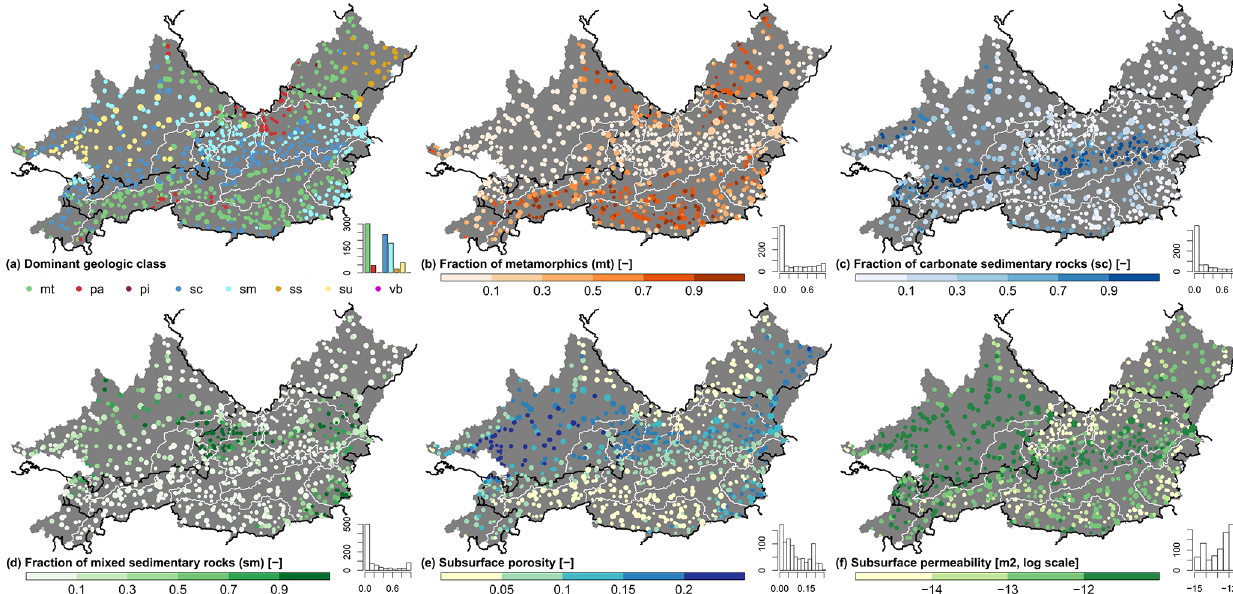
Figure 11. Spatial distribution of geological attributes representing the characteristics of the entire topographic catchment (basin delin- eation A, Fig. 2a). The histograms indicate the number of basins (out of 859) in each category. The size of the circles is proportional to the catchment area. Classes in plot (a) : mt – metamorphites, pa – acid plutonic rocks, pi – intermediate plutonic rocks, sc – carbonate sedimen- tary rocks, sm – mixed sedimentary rocks, ss – siliciclastic sedimentary rocks, su – unconsolidated sediments, vb – basic volcanic rocks. © EuroGeographics for the administrative boundaries.